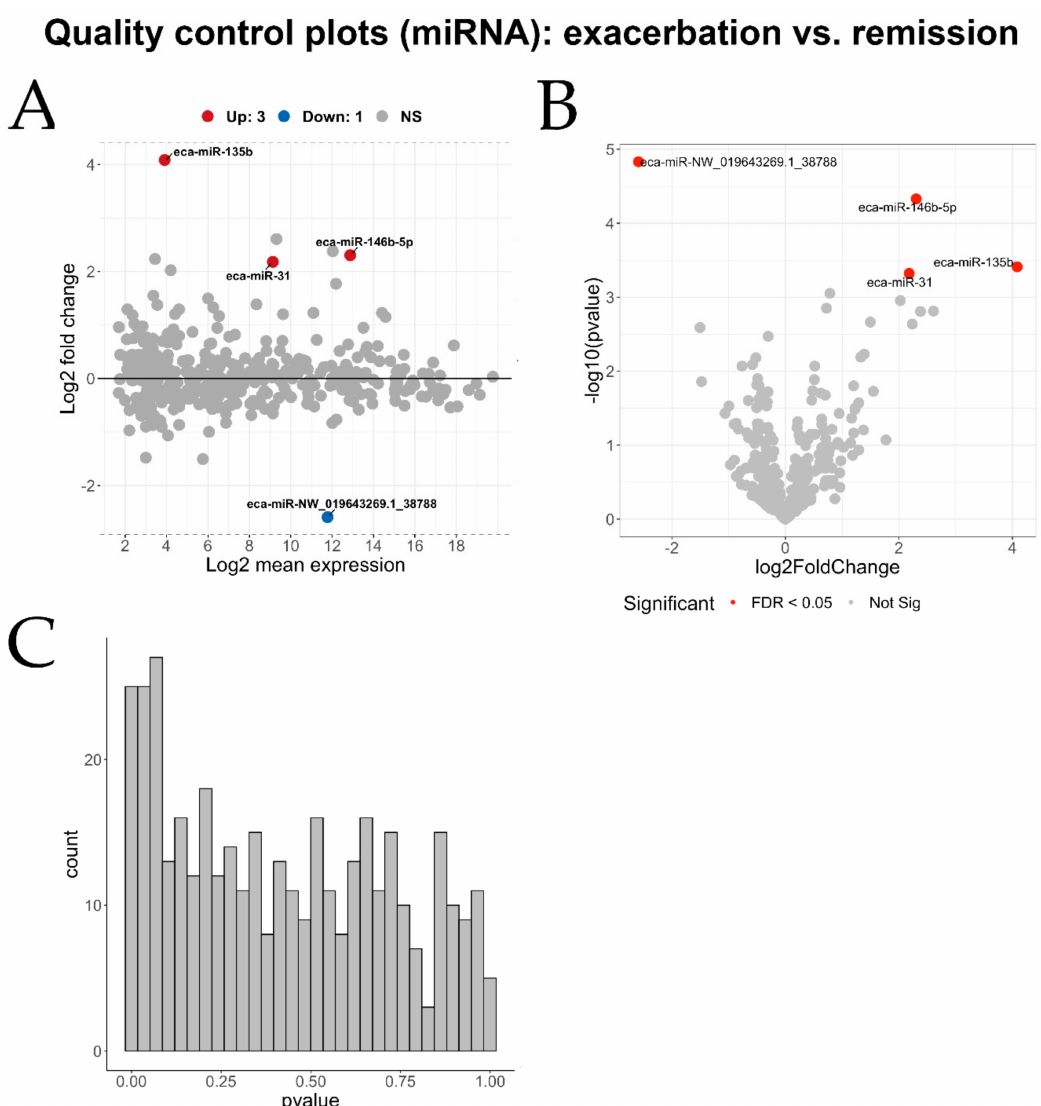
Figure A4. Quality control plots for the di ff erential miRNA expression analysis using the contrast of horses in exacerbation vs. horses in remission. An MA-plot ( A ), a Volcano plot ( B ), and a histogram of the obtained p -values ( C ) are shown. Non-significant (NS) miRNAs are indicated in grey